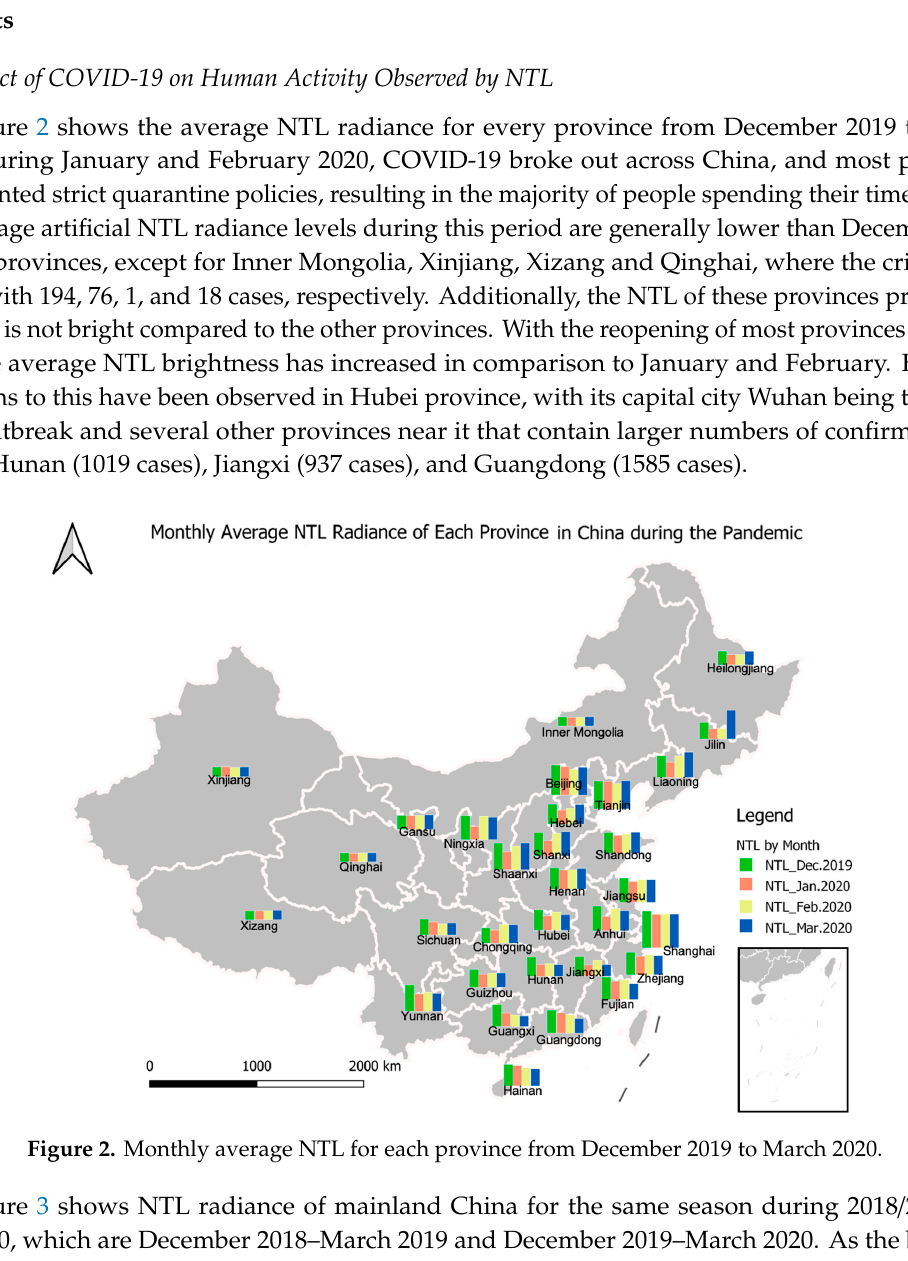
Figure 2. Monthly average NTL for each province from December 2019 to March 2020.